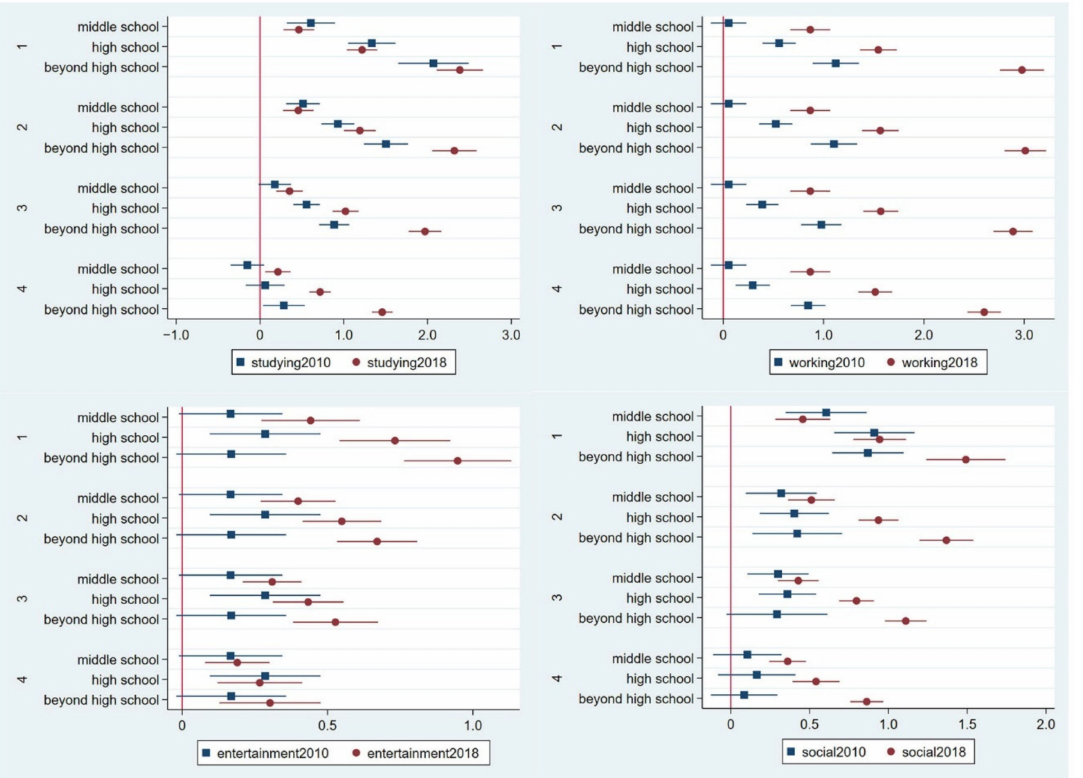
Figure 1. Results of educational background from the generalised partial proportional odds model predicting the importance of studying, working, entertainment, and social online activities in the 2010 and 2018 panels. Note: The four panels of internet activity evaluation included the 1st panel (category 1 versus categories 2, 3, 4, and 5); 2nd panel (categories 1 and 2 versus categories 3, 4, and 5); 3rd panel (categories 1, 2, and 3 versus categories 4 and 5); and 4th panel (categories 1, 2, 3, and 4 versus category 5). The detailed data are provided in Supplemental material Table